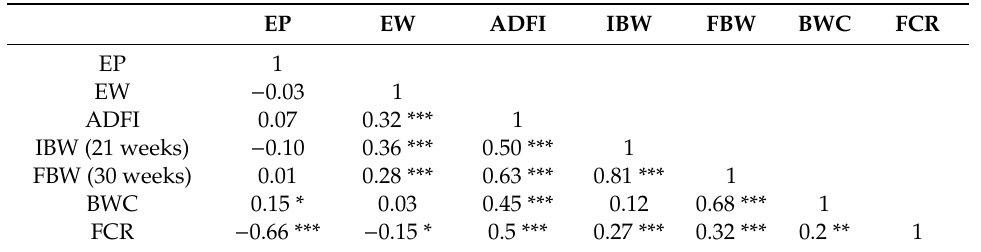
Table 3. Correlation ( r ) among hen performance traits of early-laying ISA Brown hens aged between 25 and 30 weeks old; n = 446 hens.